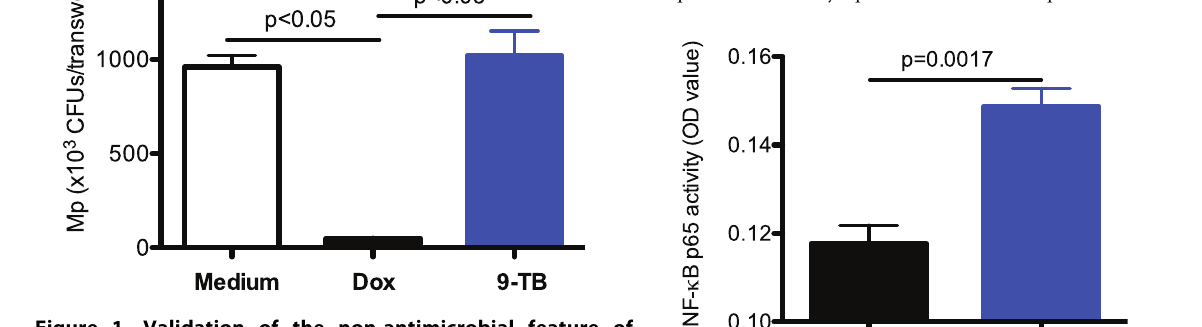
Figure 1. Validation of the non-antimicrobial feature of a tetracycline analog 9-t-butyl doxycycline (9-TB). Tracheal epithelial cells from wild-type C57BL/6 mice were isolated and cultured under air-liquid interface (ALI) condition as described in the Materials and Methods section. The effects of medium control, doxycycline (Dox, 0.5 m g/ml) or 9-TB (0.5 m g/ml) on Mp growth in the apical supernatants of epithelial cells were examined at 24 hour post infection. N=3; CFUs=colony forming units. Data are expressed as means 6 SEM.